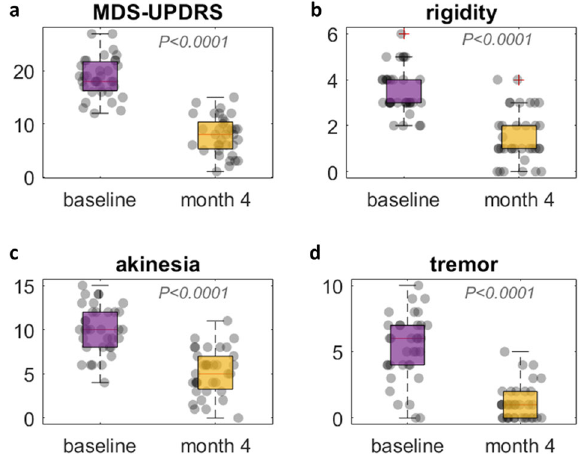
Fig. 2 Raw clinical scores at baseline and month 4. Four clinical variables ( a – d ) are shown with P -values in paired t -tests, indicating signi fi cant differences before and after treatment in all motor assessments. Each dot represents a subject. Center lines indicate the median. Box limits indicate 75th and 25th percentile. Red crosses are outliers. All scores are corresponding to the treated